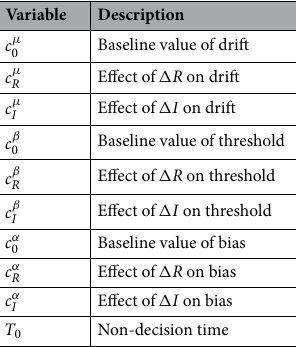
Table 1. Free parameters in the drift diffusion model. Note that all parameters are horizon dependent giving a total of 20 free parameters overall, per